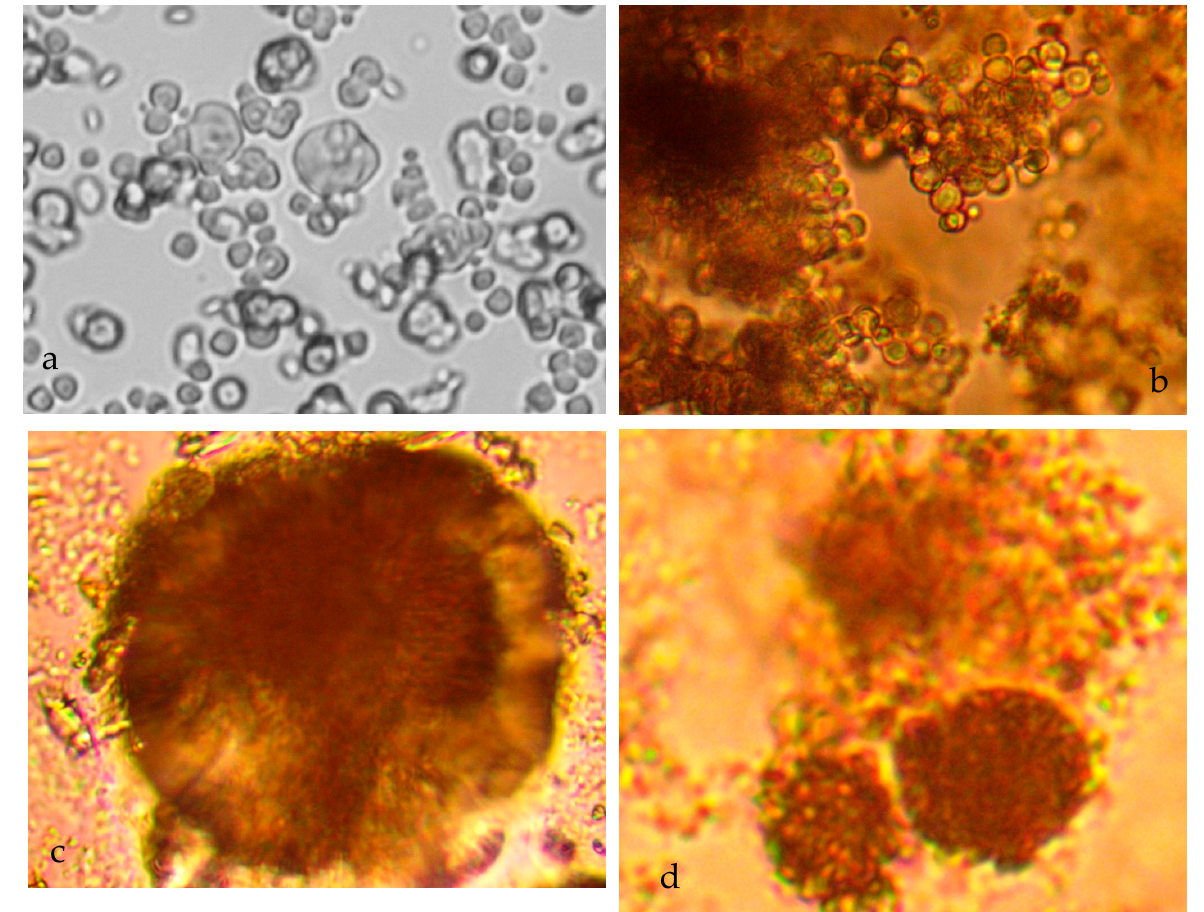
Figure 6. Initial colloids: ( a ), Fe@Ca@Zn polymer (Supplementary Information, Figure S2a). Field of view = 0.065 mm; Doughnut shapes are an optical illusion due to the fluid filled core of the colloid spheres. ( b ), Initial fluid filled colloids accumulating to form an amorphous colloidal mass: Example A1a. Field of view = 0.128 mm; ( c ), Fe(b)@Ca(a)@Mn(a)@Mg(a)@HCOOH polymer; 0.09 mm diameter colloid aggregate sphere constructed from coalesced colloids. Field of view = 0.11 mm. ( d ), Example A2b. Spheres aggregating to form a larger particle; Field of view = 0.047 mm.